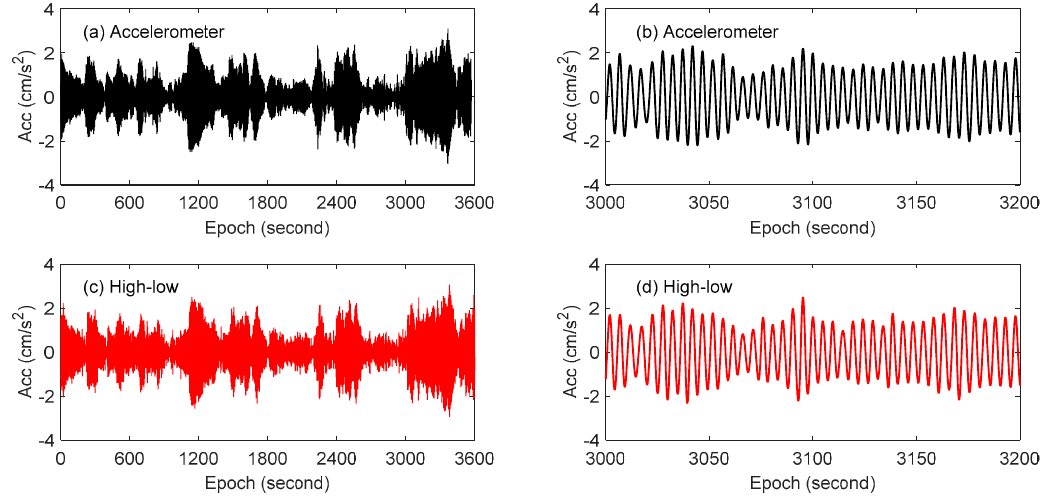
Figure 12. Acceleration comparison of GPS and Accelerometer: ( a ) accelerometer result, ( b ) is enlargement of the detail of ( a ); ( c ) combining high- and low-rate GPS method, ( d ) is enlargement of the detail of ( c ).